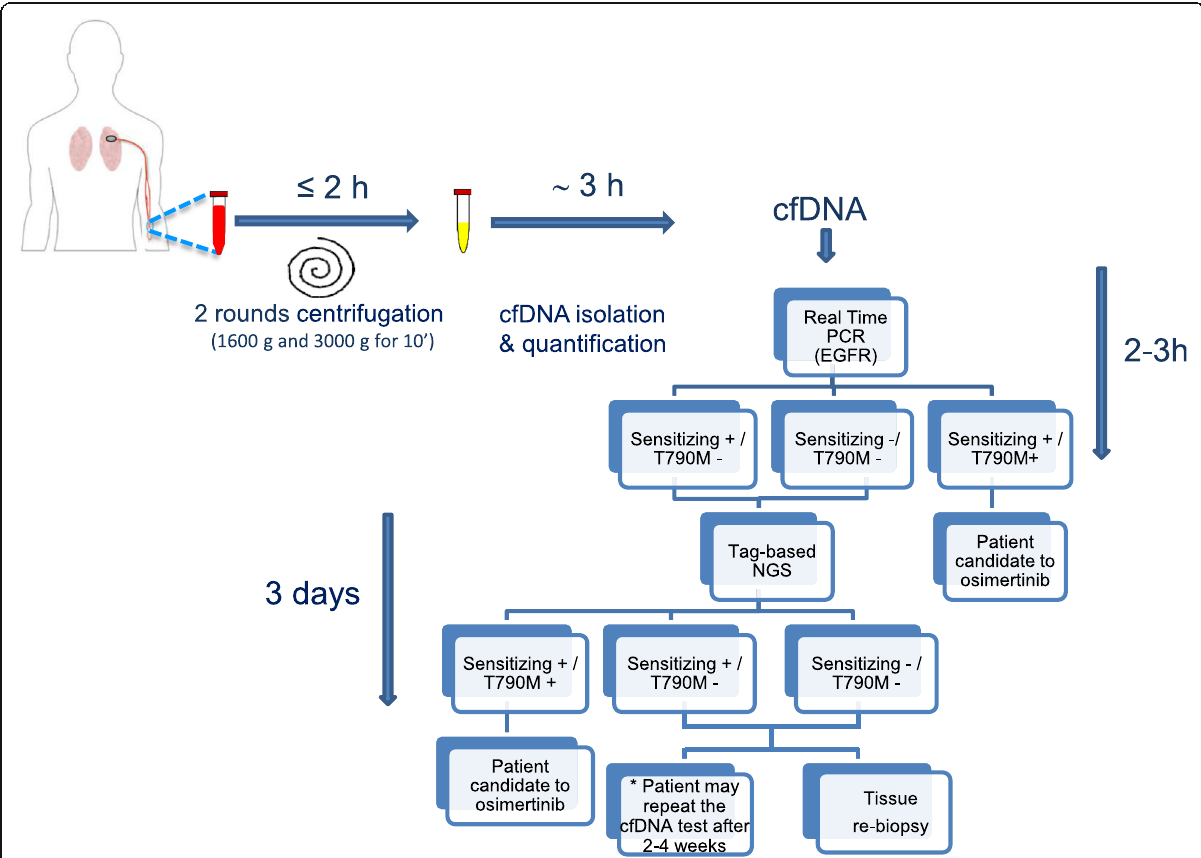
Fig. 4 Workflow for the identification of EGFR T790M in TKI progressed patients with advanced NSCLC. Procedures and timing of cfDNA EGFR testing from sample arrival is represented together with the decision algorithm suggested. *Patients resulting T790M negative after NGS analysis on cfDNA can undergone tumor biopsy, when feasible. Alternatively, the T790M negative patient can be retested on a second cfDNA after 2 – 4weeks following the National Scientific Society recommendations on liquid biopsy